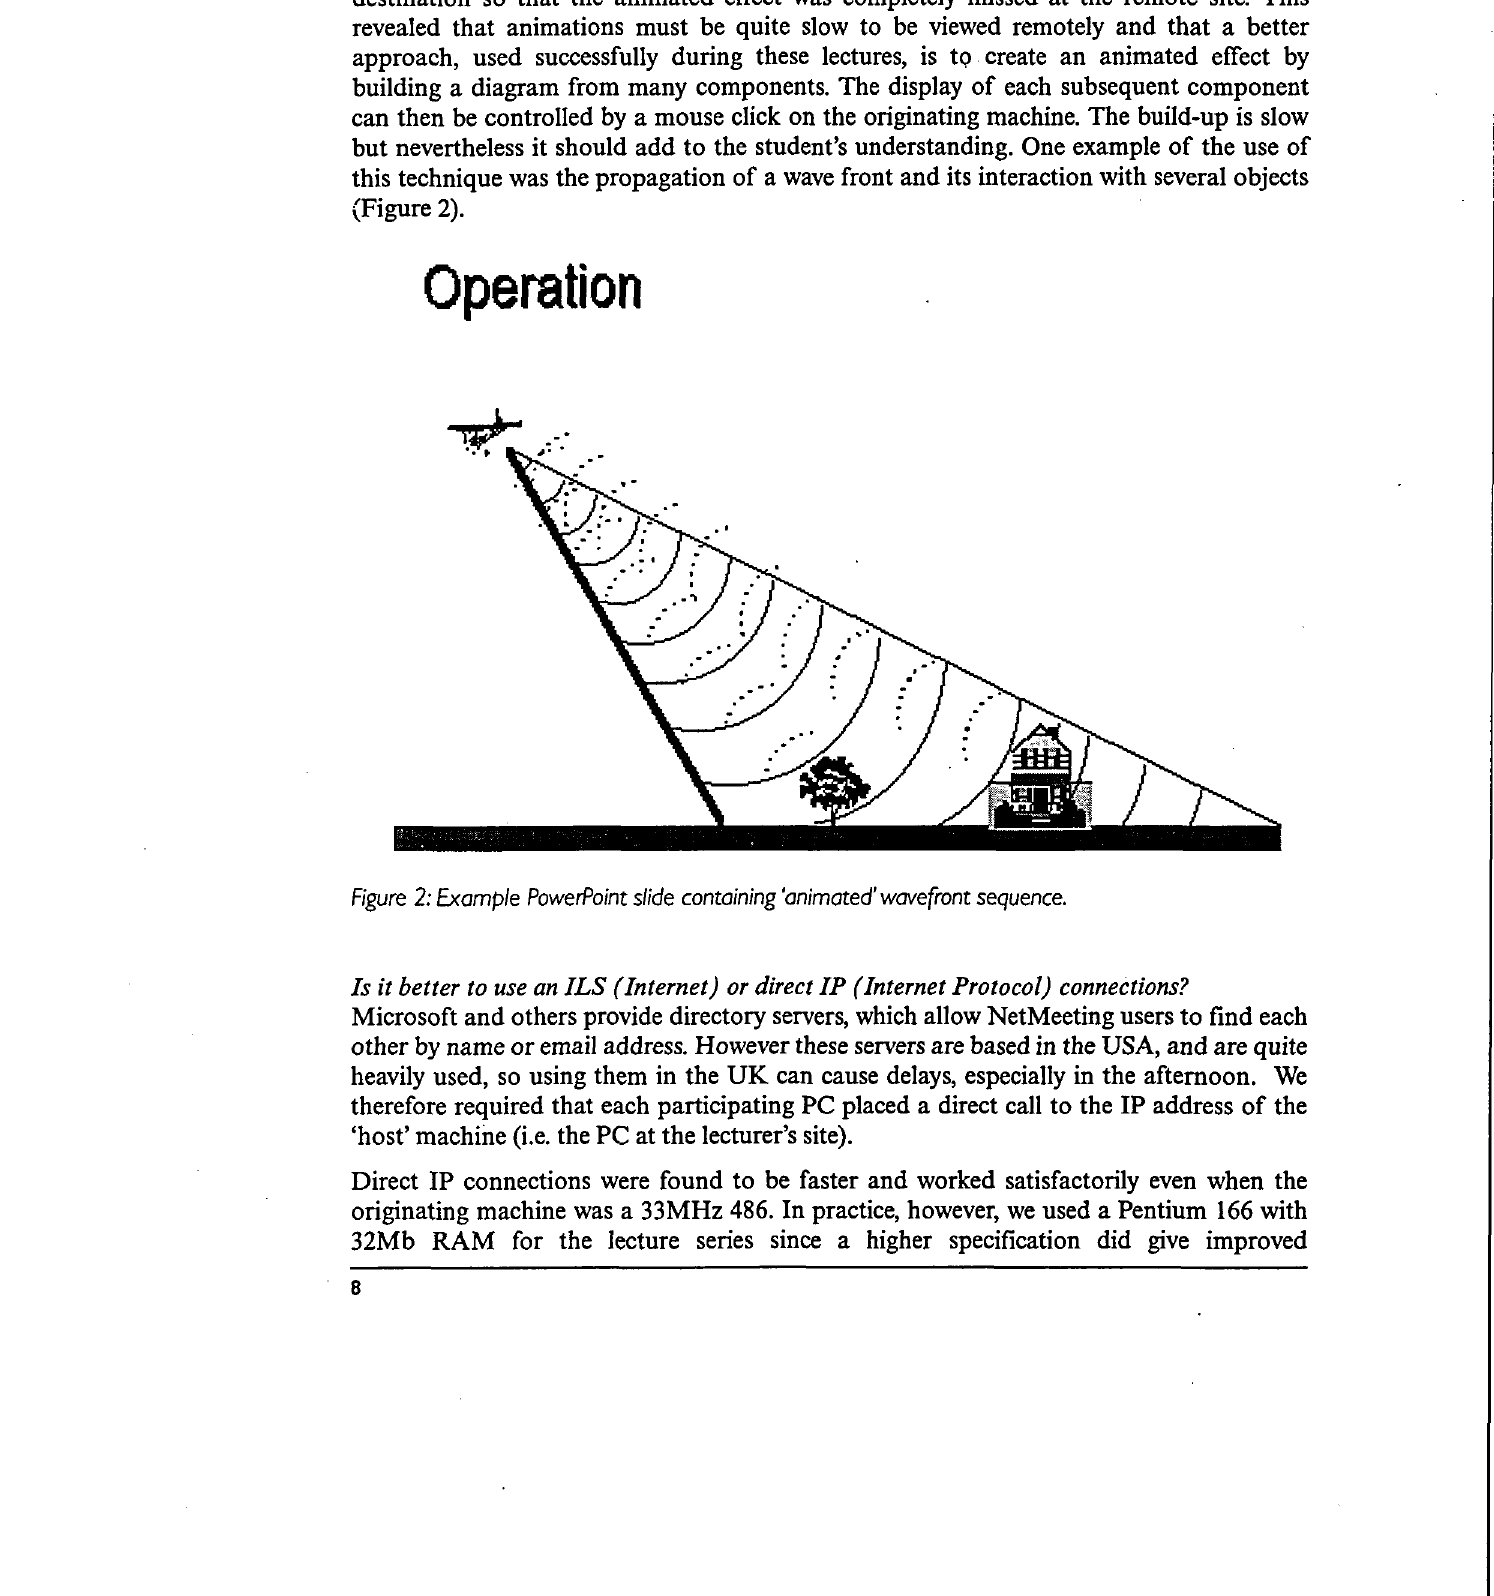
Figure 2: Example PowerPoint slide containing 'animated wavefront